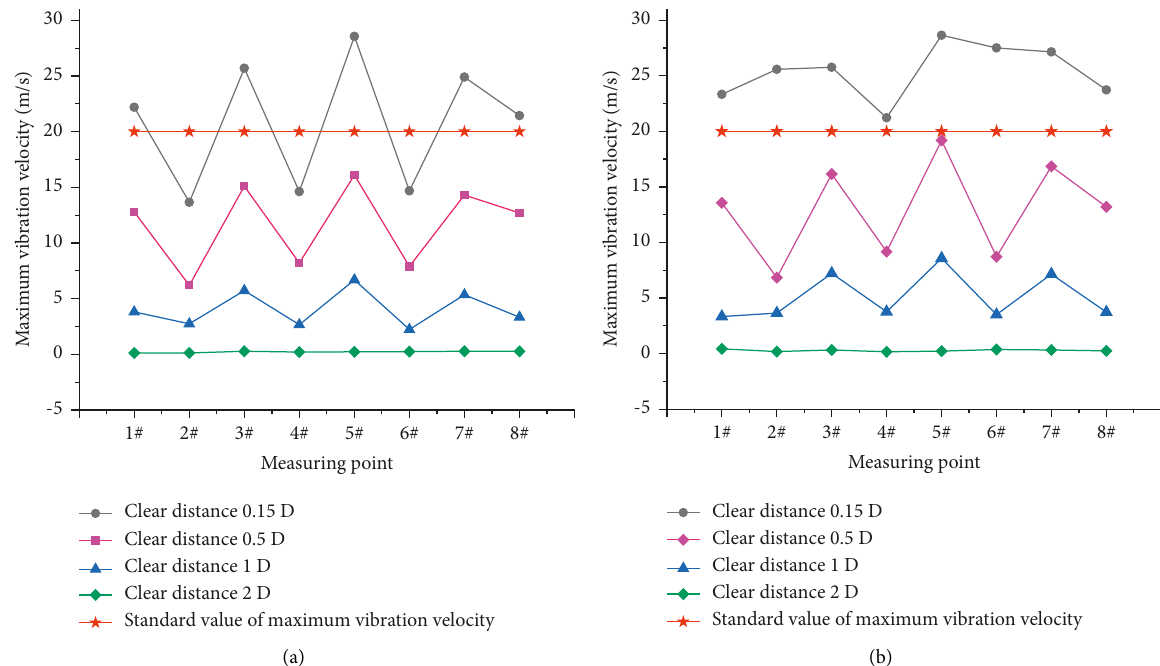
Figure 16: Vibration velocity of each measuring point under different clear distance conditions. (a) Excavated by upper step and (b) excavated by lower